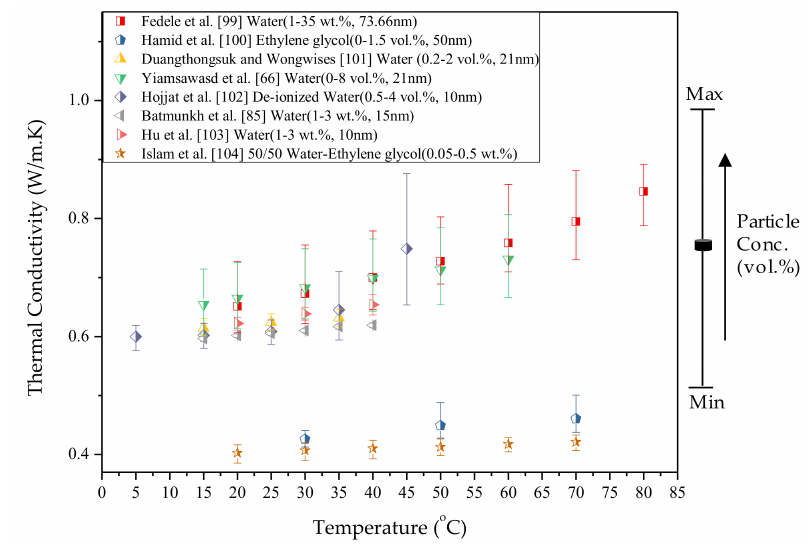
Figure 16. Thermal conductivity of TiO 2 nanofluid as a function of temperature from various